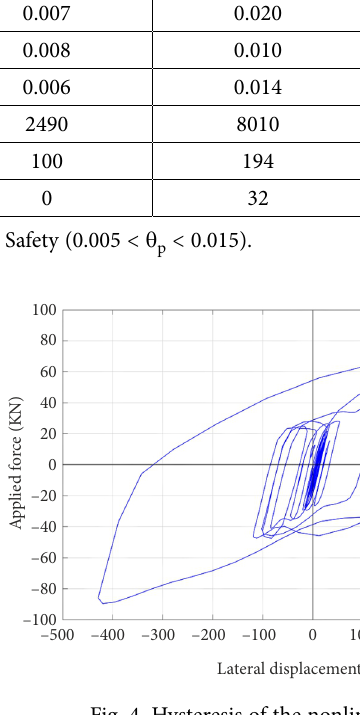
Fig. 4. Hysteresis of the nonlinear behaviour of rubber